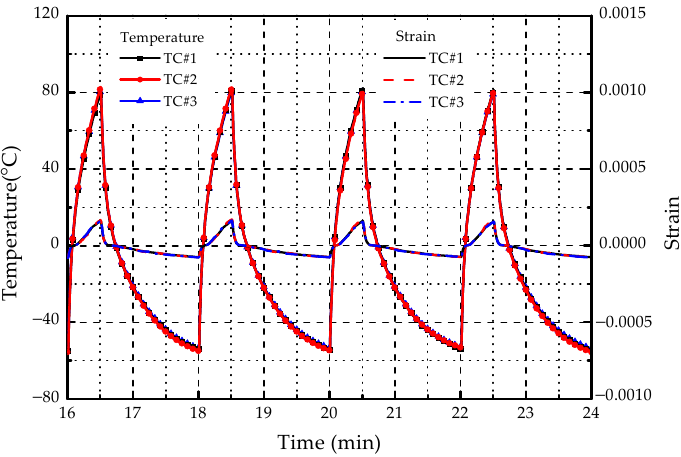
Figure 9. Variation of temperature and strain in thermal cycles.